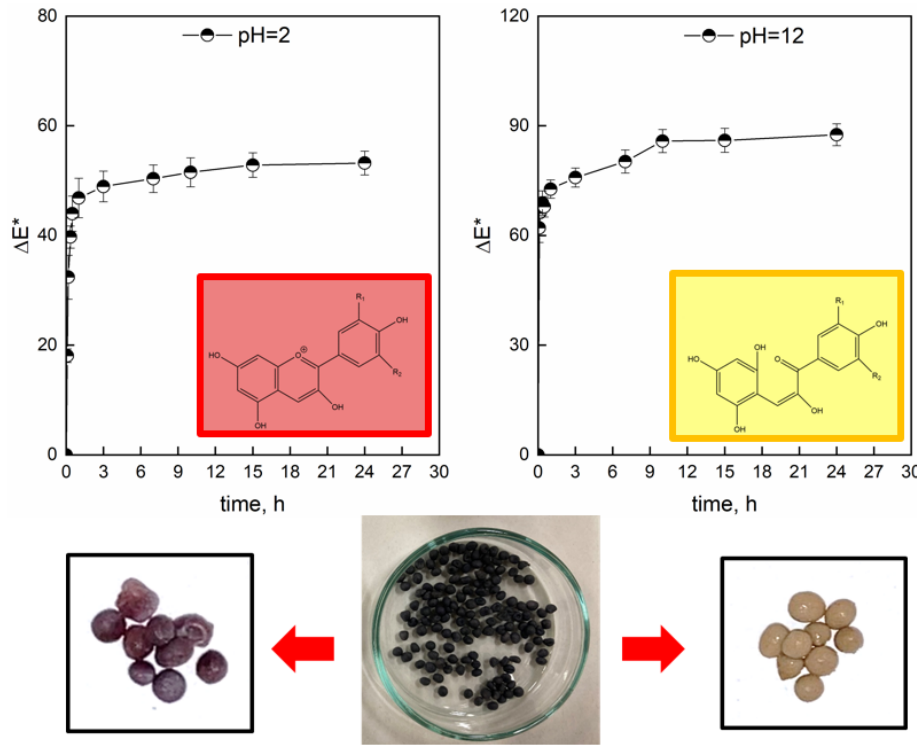
Figure 8. Colorimetric responses of LSBs at pH = 2 and pH = 12. Below: pictures of LSBs in different buffer pH solutions after 24 h.